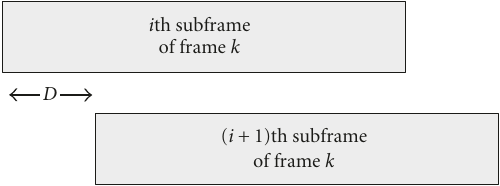
Figure 3: Delay between consecutive